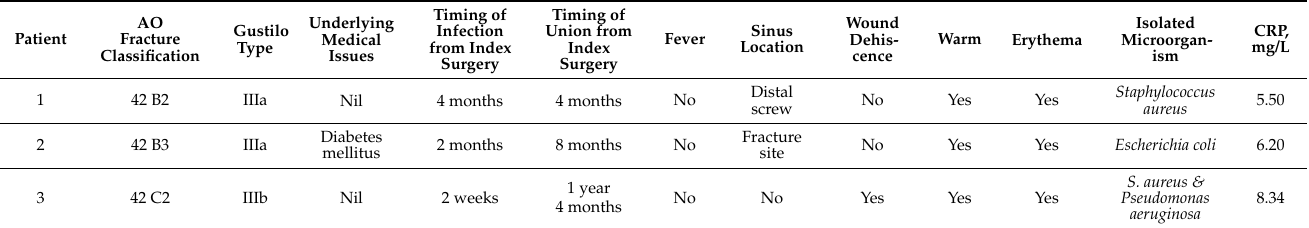
Table 2. Characteristics of patients with surgical site infection according to CDC diagnostic